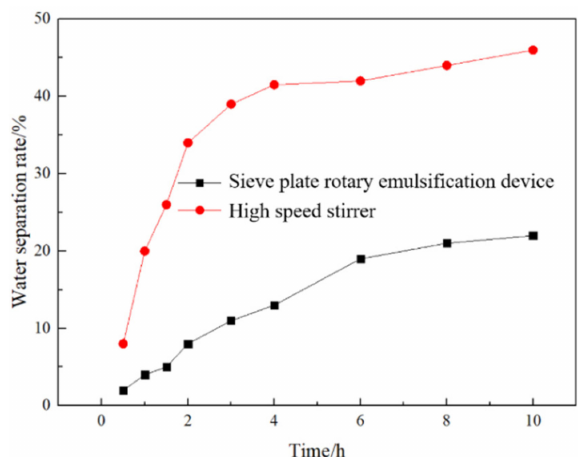
Figure 7. Water separation rate of emulsions prepared by di ff erent devices (stirring speed of 300 r /